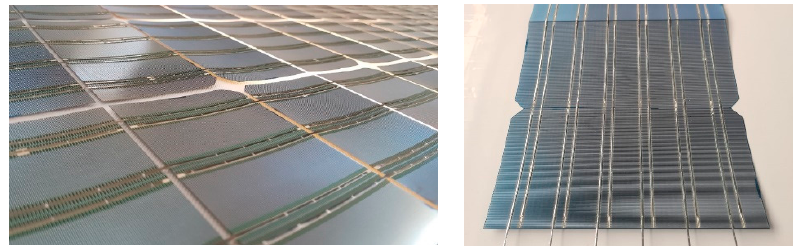
Figure 10. Interconnection of ZEBRA half cells ( left ) and “Negative Gap Technology” at IBC ( right ) .